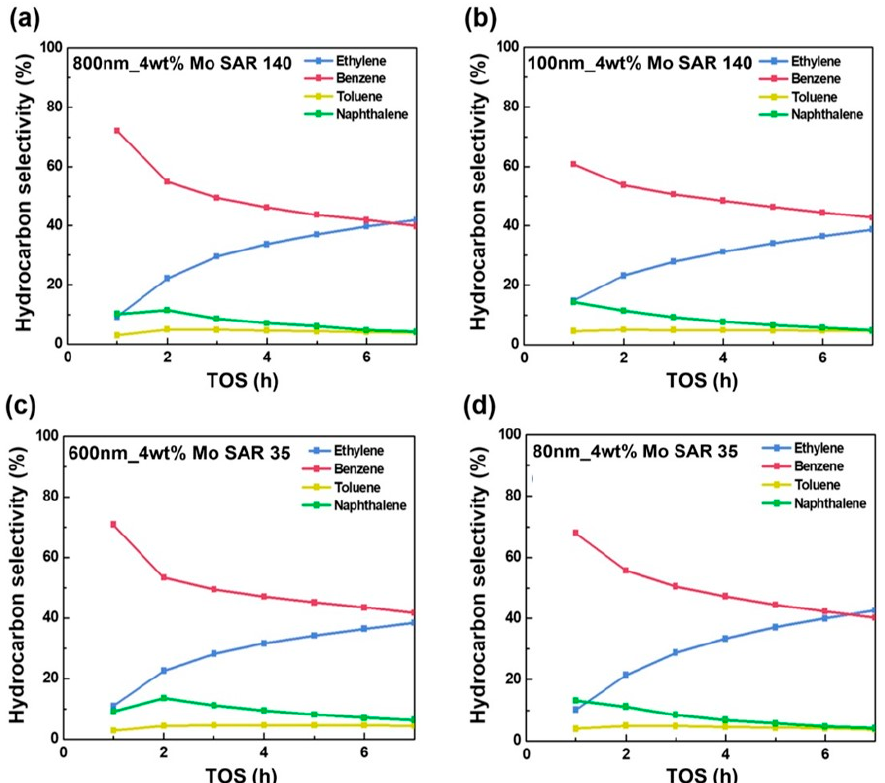
Figure 4. Hydrocarbon selectivity of Silicalite-1@Al-ZSM-5 zeolite samples as a function of TOS: ( a ) 800 nm_Mo SAR 140, ( b ) 100 nm_Mo SAR 140, ( c ) 600 nm_Mo SAR 35, and ( d ) 80 nm_Mo SAR 35.